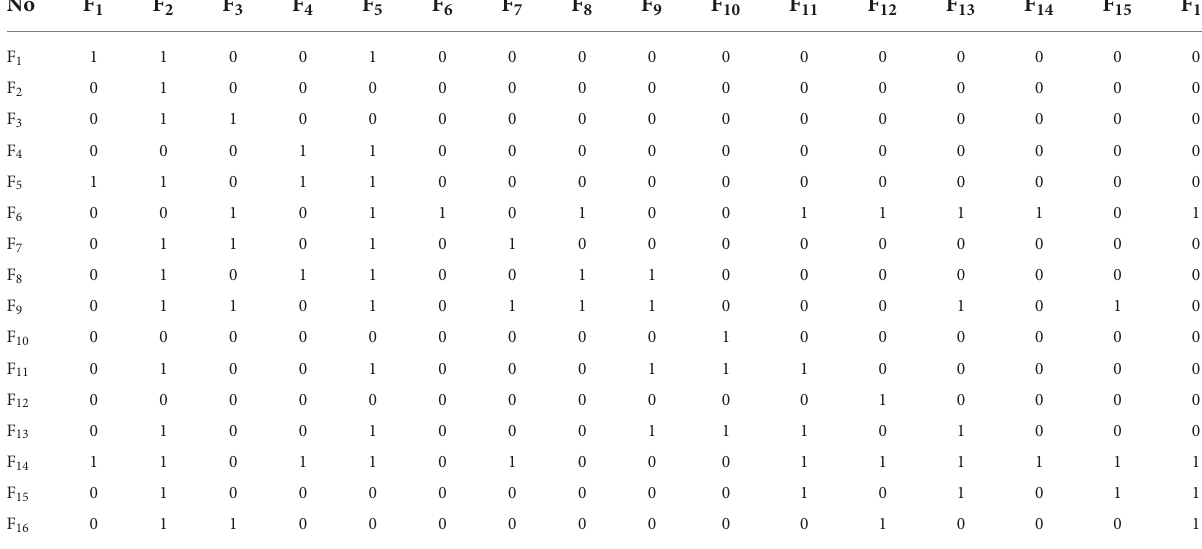
TABLE 4 Adjacency matrix A of 16